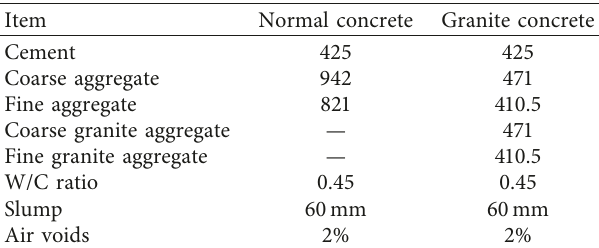
Table 5: Concrete mix design for the normal samples and samples with 50% granite